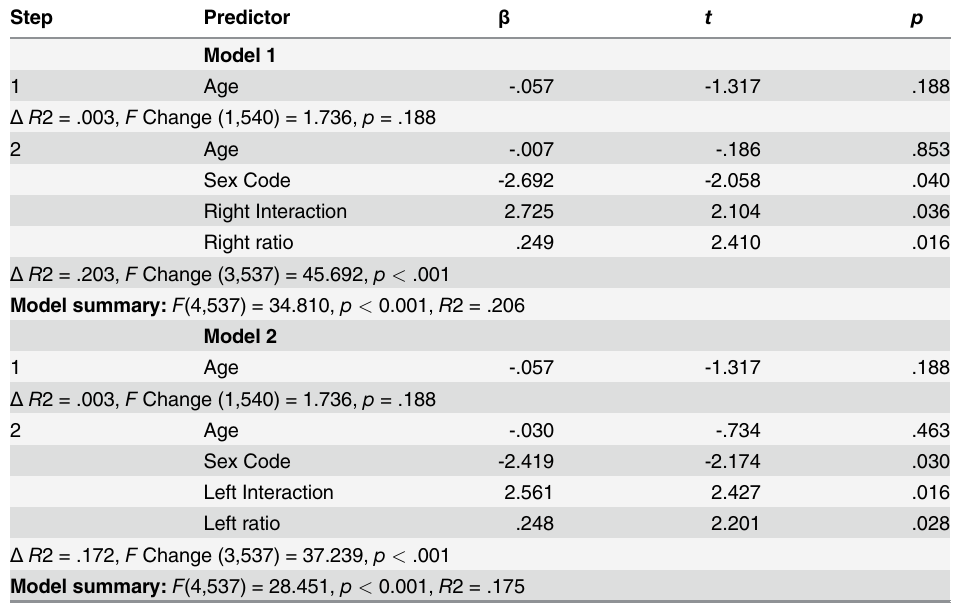
Table 2. Regression of half-marathon time in seconds on digit ratio (right in model 1, left in model 2), sex and sex-ratio interaction (right in model 1, left in model 2). Step